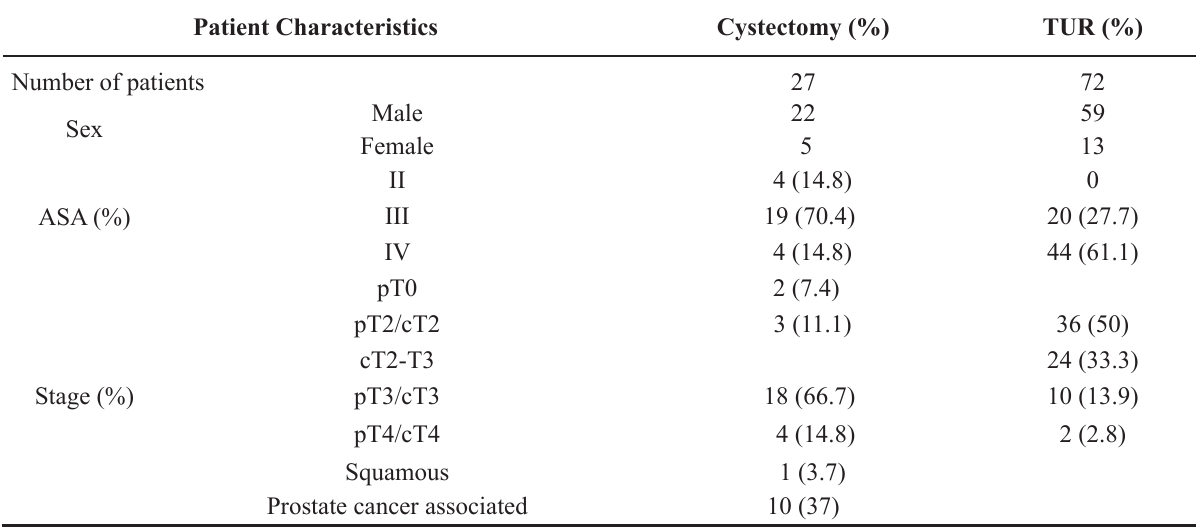
Table 1– Patient characteristics. Patient